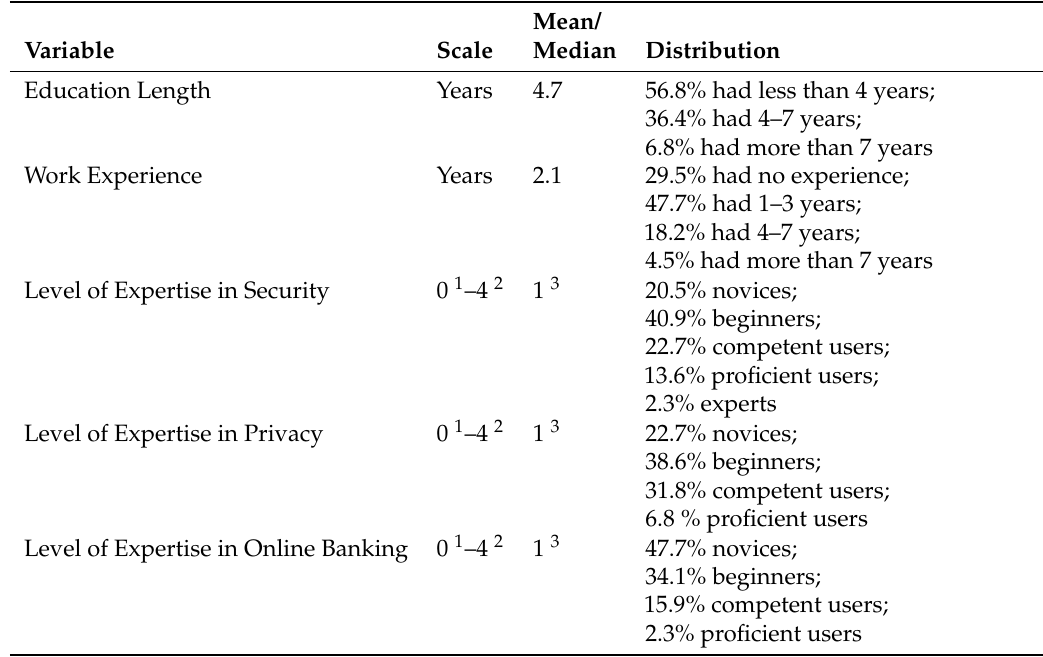
Table 4. Overall Participants’ Demographic